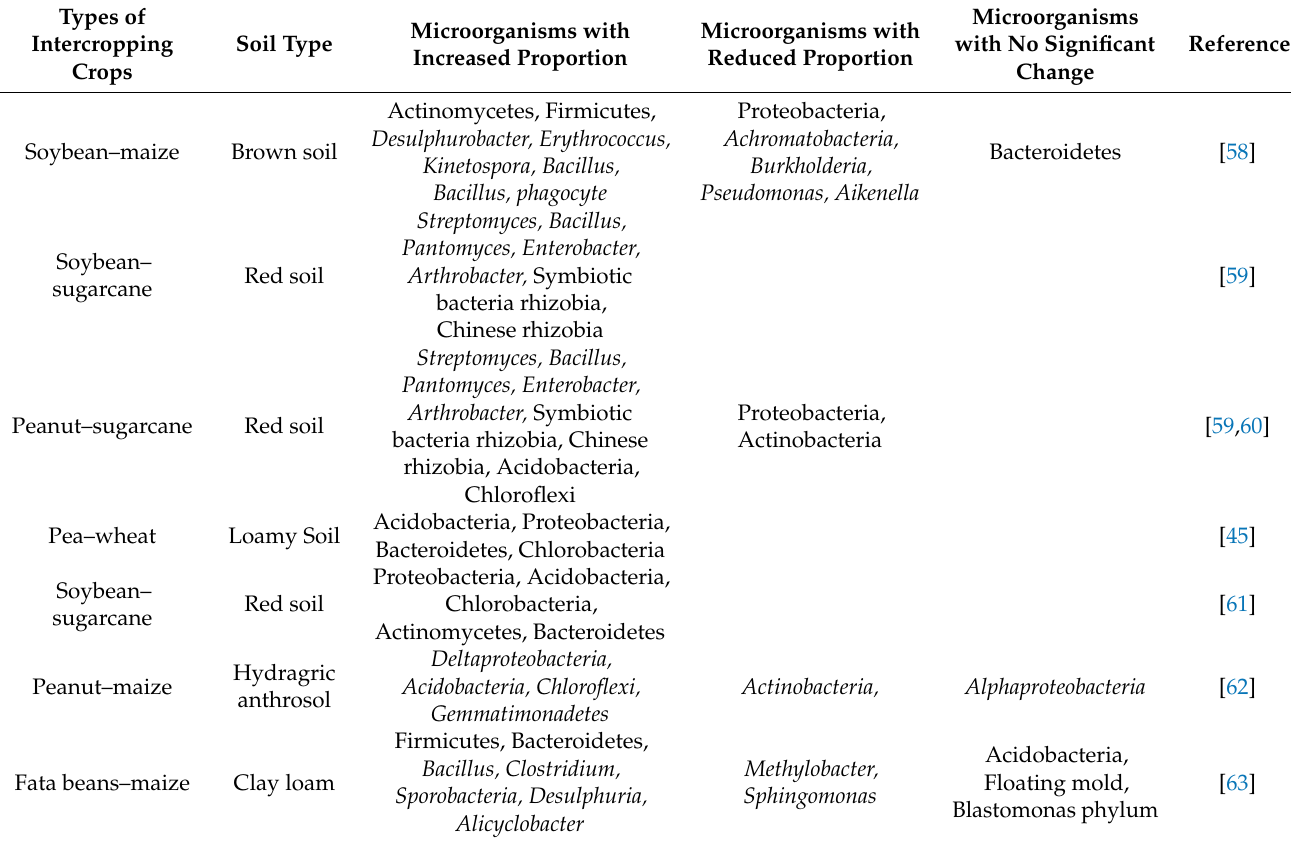
Table 2. Effects of legume–cereal intercropping on rhizosphere microorganisms of